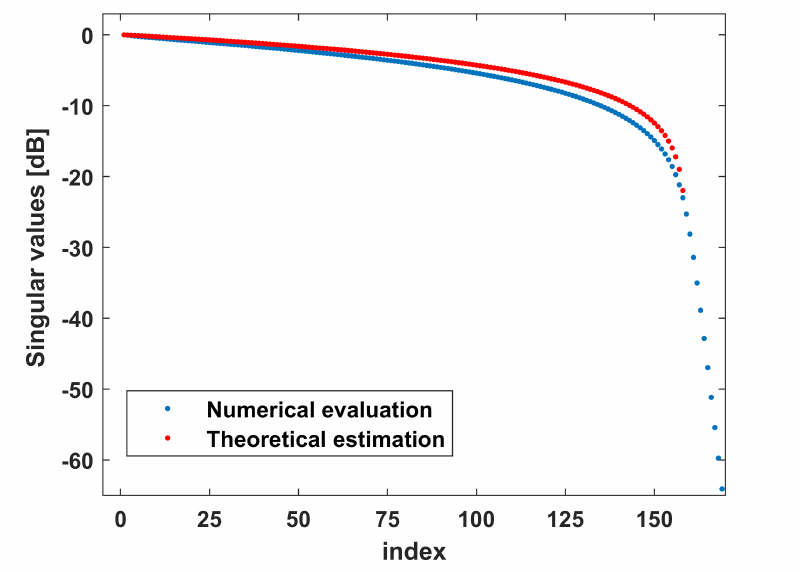
Figure 5. Singular values of A 1 numerically computed and their analytical estimation for the case a = 20 λ , z 1 = 5 λ , X 1 = 37.03 λ ( η ( X 1 , z 1 ) =